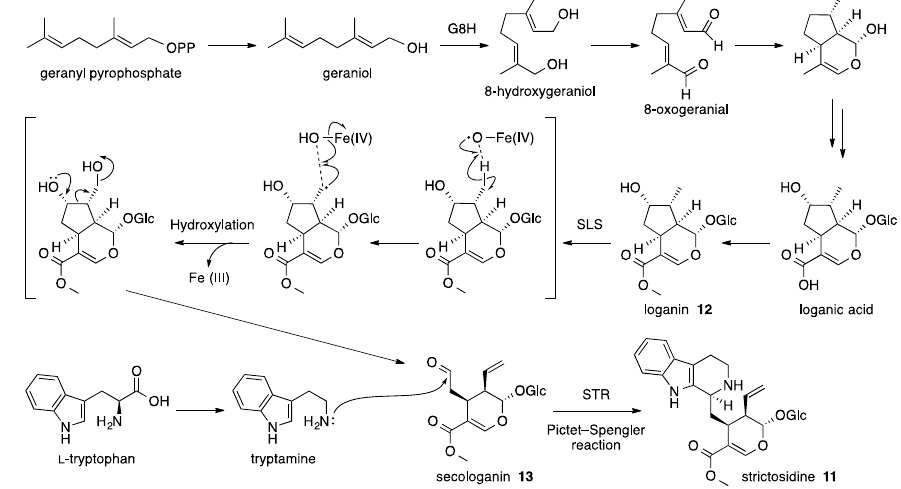
Figure 9. Proposed biosynthetic pathway of strictosidine 11 , the universal intermediate in the monoterpene indole alkaloid biosynthesis [38]. G8H, geraniol 8-hydroxylase; SLS, secologanin synthase; STR, strictosidine synthase.